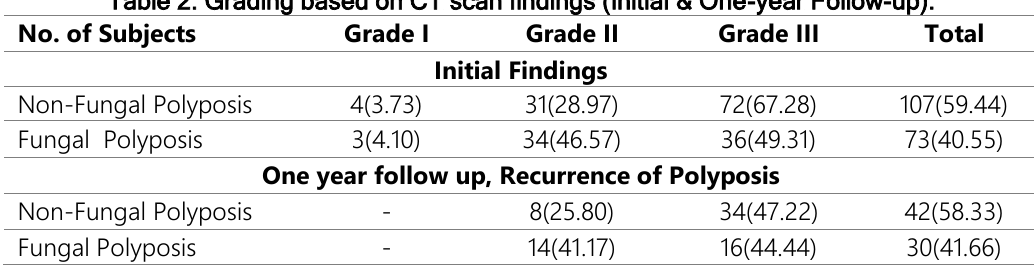
Table 2: Grading based on CT scan findings (Initial & One-year